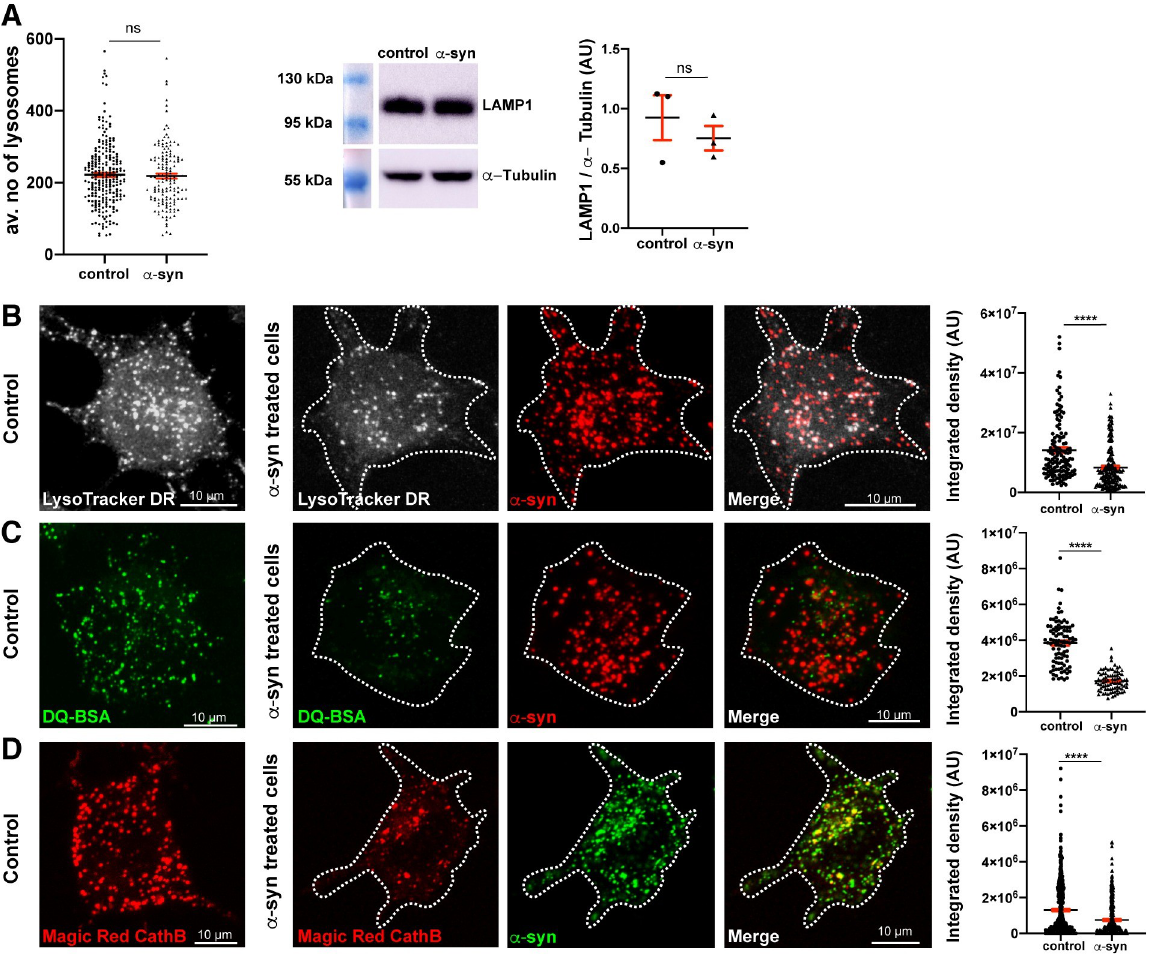
Fig 2. α -Syn fibrils affect the function of lysosomes. (A) Average number of lysosomes (LAMP1+ puncta) per cell in control (222 ± 6) and in α -syn fibril-treated CAD cells for 18 hours (218 ± 7) is presented. Mean ± SEM, n = 5 (50 cells per condition). ns = not significant by Whitney– Mann U test (left panel). Western blot showing LAMP1 and α -tubulin expression in control and α -syn fibril-treated cells. Integrated density of LAMP1 protein expression levels normalized to α -tubulin in control (0.9 ± 0.2) and α -syn fibril-treated cells (0.7 ± 0.1) are presented in AU. Mean ± SEM, n = 3. ns = not significant by paired t test. (B) Representative confocal images of control and Alexa 568–tagged α -syn fibrils challenged CAD cells (18 hours), labeled with LysoTracker DR (20 nM for 20 minutes; LysoTracker DR is pseudo colored in gray). Dashed lines represent the cell contour. Average integrated density of control cells (1.4 × 10 7 ± 9 × 10 5 ) and α -syn fibril-treated cells (8.3 × 10 6 ± 5 × 10 5 ) is presented. Mean ± SEM, n = 3 (40 cells per condition). ���� P < 0.0001 by Mann–Whitney U test. Scale bar: 10 μ m. (C) Representative confocal images of control and Alexa 568–tagged α -syn fibrils (red) challenged CAD cells for 18 hours, treated with DQ-BSA (green) for 90 minutes. Dashed lines represent the cell contour. Average integrated density measured for control cells (3.8 × 10 6 ± 1 × 10 5 ) and α -syn fibril-treated cells (1.7 × 10 6 ± 6 × 10 4 ) is presented. Mean ± SEM, n = 3 (25 cells per condition). ���� P < 0.0001 by Mann–Whitney U test. Scale bar: 10 μ m. (D) Representative confocal images of control and Alexa 488-tagged α -syn fibrils (green) challenged CAD cells for 18 hours treated with 1X Magic Red CathB (red). Dashed lines represent the cell contour. Average integrated density measured for control cells (1.3 × 10 6 ± 6 × 10 4 ) and α -syn fibril-treated cells (7.5 × 10 5 ± 5 × 10 4 ) is presented. Mean ± SEM, n = 5 (100 cells per condition). ���� P < 0.0001 by Mann–Whitney U test. Scale bar: 10 μ m. The data underlying this figure may be found in S1 Data. α -syn, α -synuclein; AU, arbitrary unit; CAD, Cath.a-differentiated; CathB, Cathepsin B; LAMP, lysosome-associated membrane protein; LysoTracker DR, LysoTracker Deep Red.